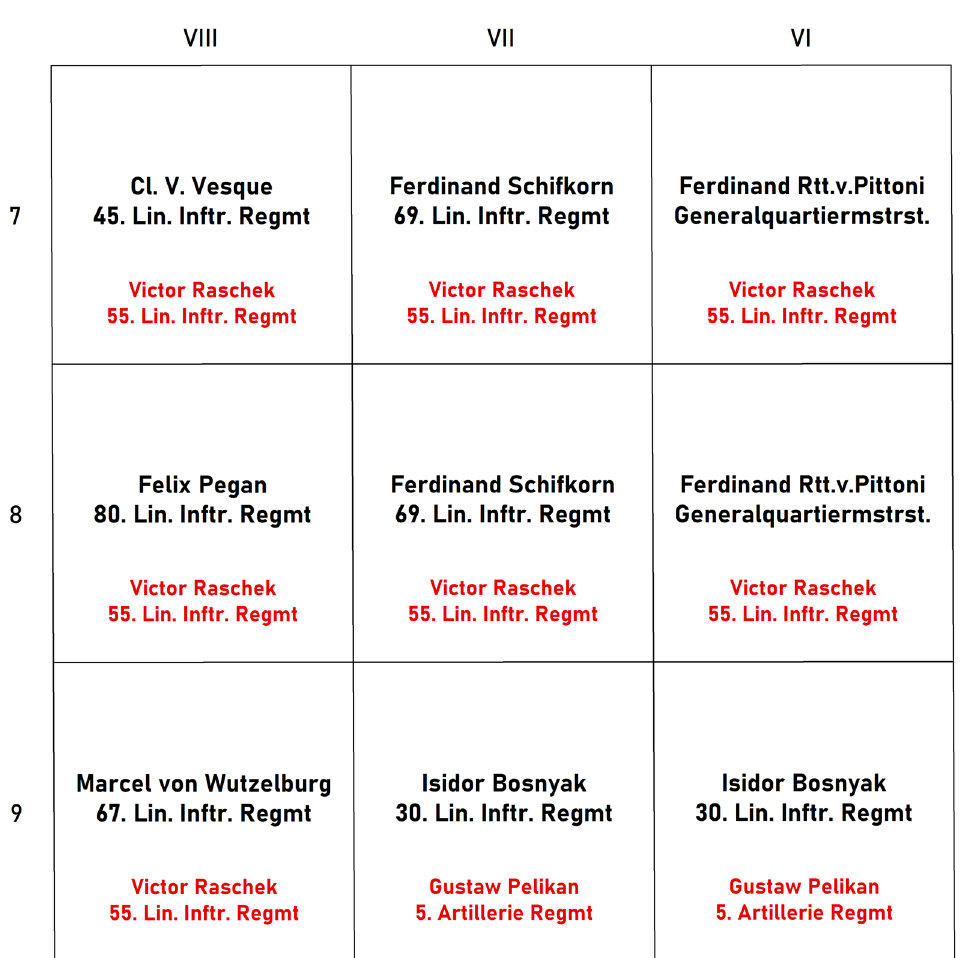
Fig. 5. Excerpt from the index with the sheet authors and their military units listed. Surveyors and drafters are in black, and description writers are in